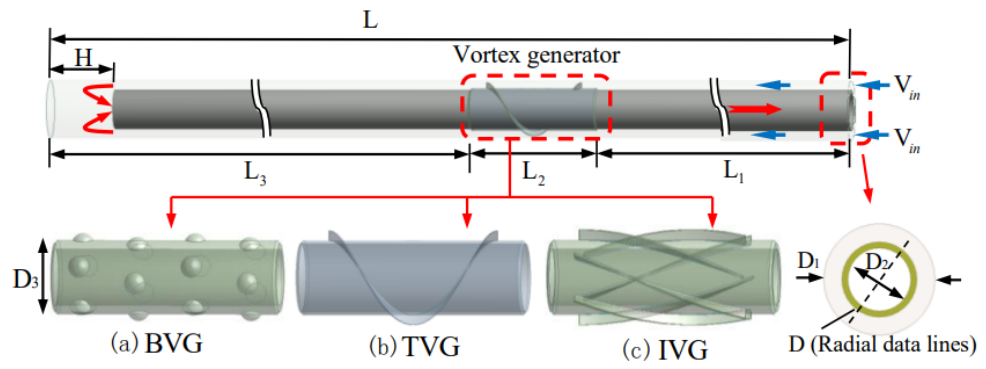
Figure 2. Geometric model of coaxial borehole heat exchanger. Table 1. Geometrical parameters of coaxial borehole heat exchanger with a vortex generator. Parameter